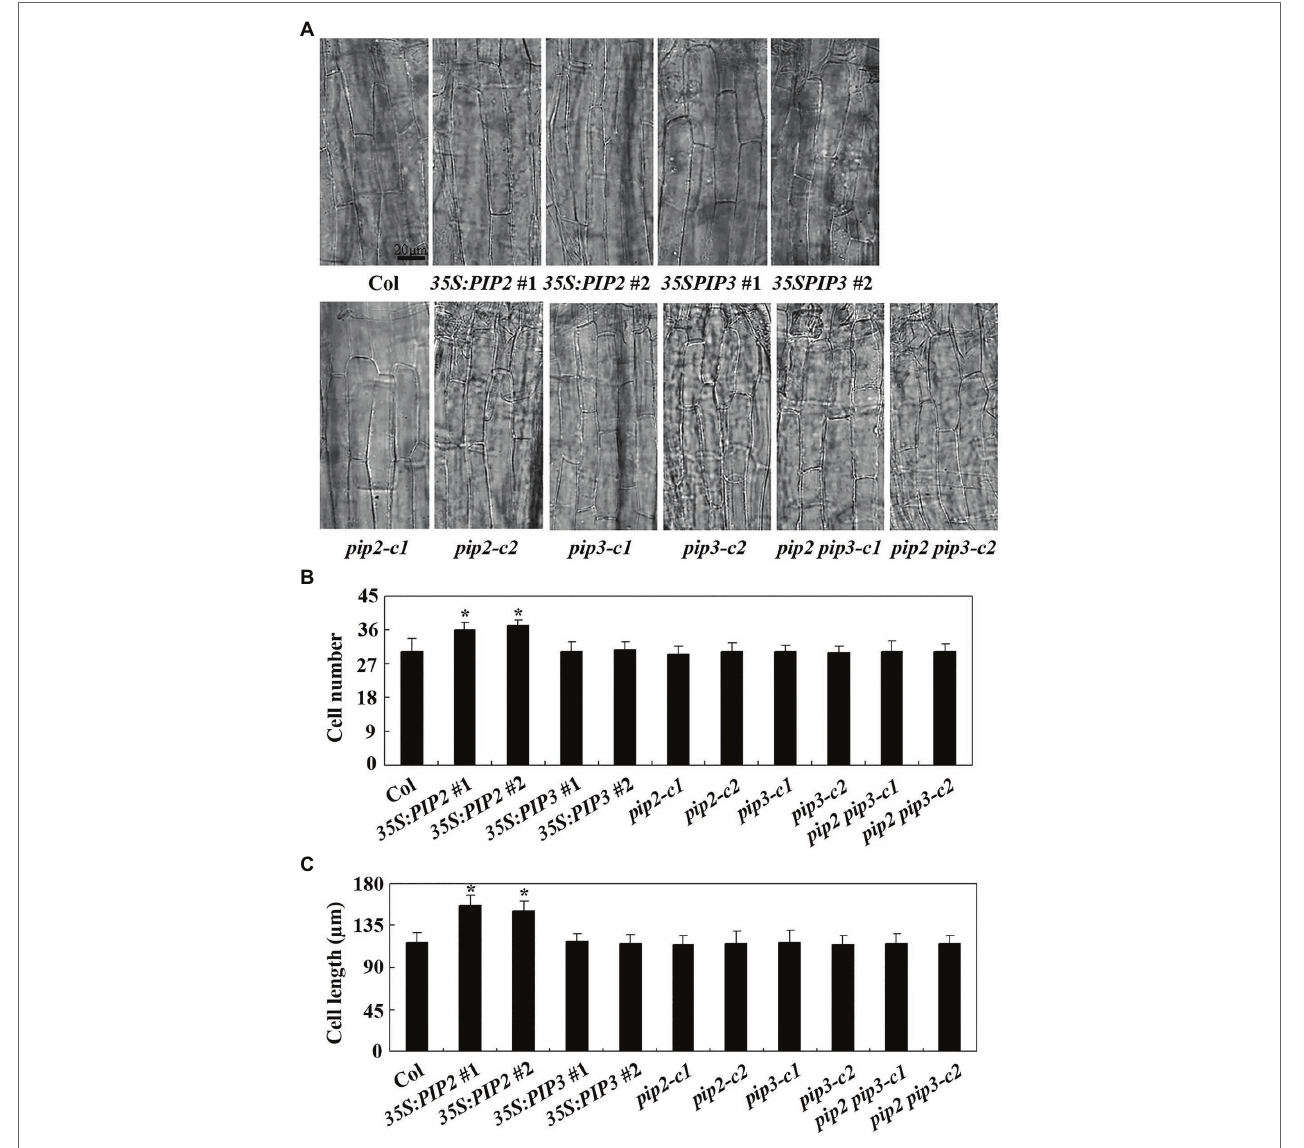
FIGURE 7 | PIP2 affects cell prolification and cell elongation in hypocotyls. (A) Hypocotyl cells in seedlings of the Col wild type, the 35S:PIP2 and 35S:PIP3 transgenic plants, and the pip2 , pip3 , and pip2 pip3 mutants. Four-day-old dim light-grown seedlings were fixed and pictures were taken under an OLYMPUS BX53 microscope. (B) Number of hypocotyl cell in seedlings of the Col wild type, the 35S:PIP2 and 35S:PIP3 transgenic plants, and the pip2 , pip3 and pip2 pip3 mutants. Cell number of a single cell line of the 4-day-old seedlings grown under dim light was counted under an OLYMPUS BX53 microscope. Data represent the mean ± SD of 10–12 seedlings. *significantly different from that of the Col wild type seedlings (student’s t -test, p < 0.001). The experiments were repeated three times with similar results. (C) Hypocotyl cell length in seedlings of the Col wild type, the 35S:PIP2 and 35S:PIP3 transgenic plants, and the pip2 , pip3 , and pip2 pip3 mutants. Length of the second row cells from the top to the base of the hypocotyls epidermis in longitudinal direction were was measured by using Image J. Data represent the mean ± SD of 22–29 seedlings. *significantly different from that of the Col wild type seedlings (student’s t -test, p < 0.001). The experiments were repeated three times with similar